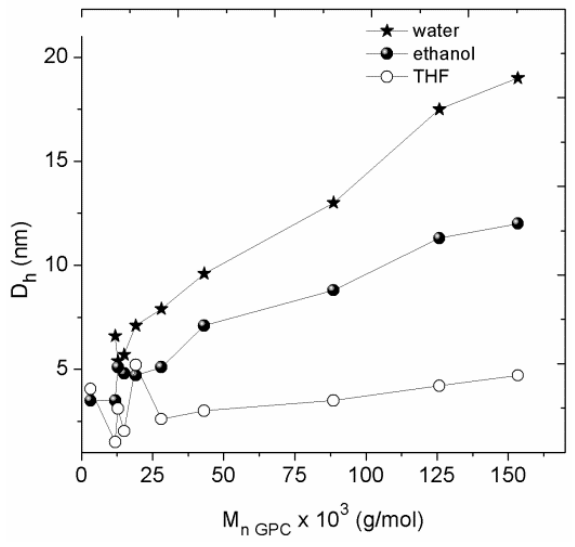
Figure 3. DLS measurements. Evolution of the D h of the star (PNVCL) 6 polymers as a function of the molecular weight ( c = 1 mg/mL).